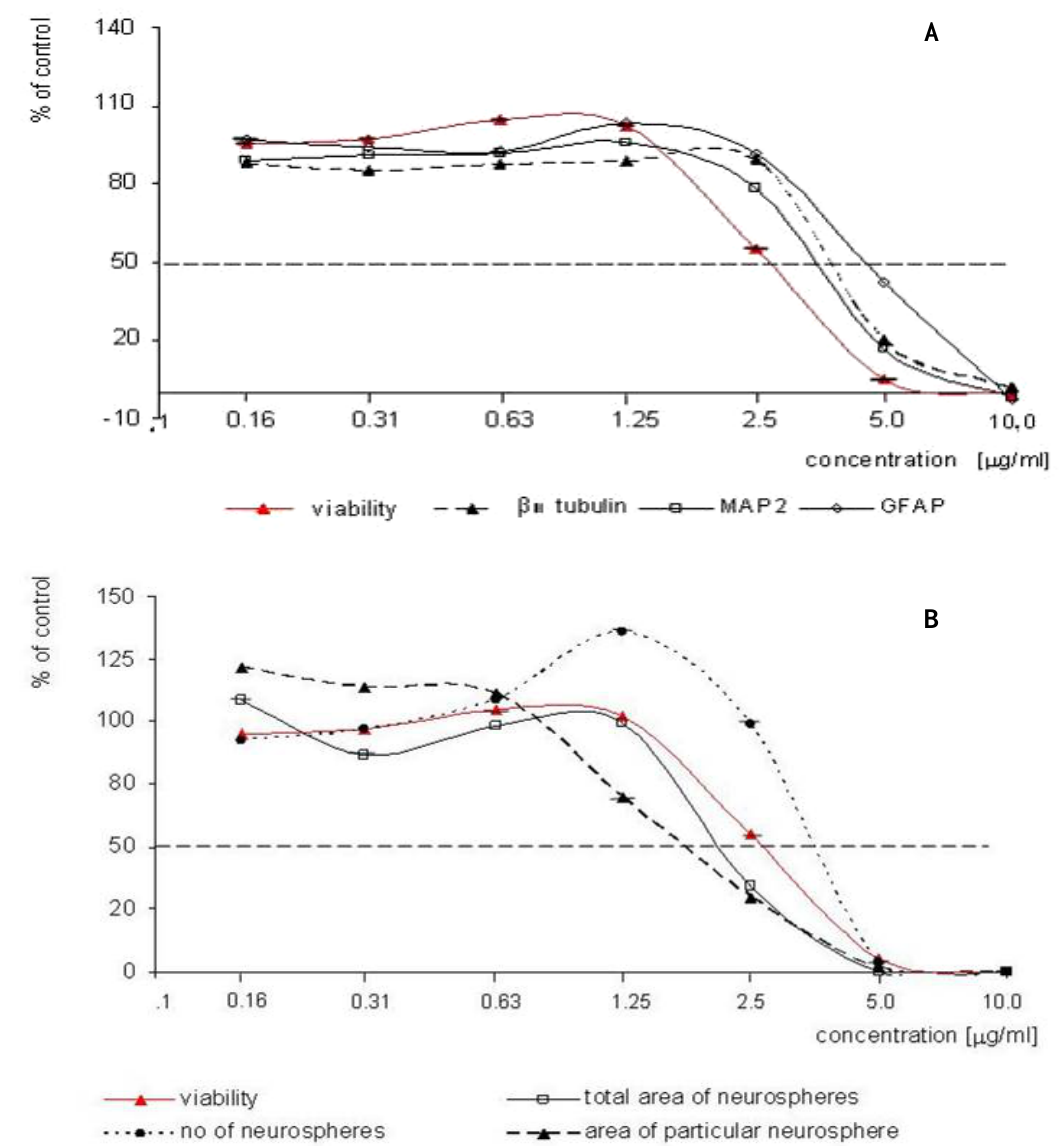
Figure 2. Representative concentration-response curves illustrating an effect of ochratoxin A on cytotoxicity (NRU test) and differentiation (six different endpoints) in micromass embryo midbrain cells cultured in vitro . The cytotoxic concentration of 2.5 µg/mL, mentioned in Table 1, resulted in increasing the number of neurospheres and decreasing of their area